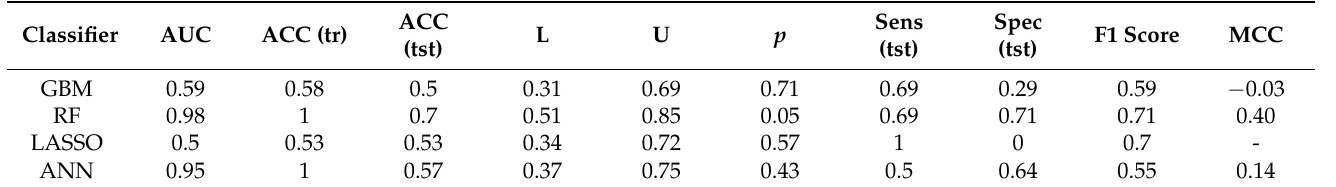
Table 4. Performance comparison of the different classifiers for the developed machine learning models.